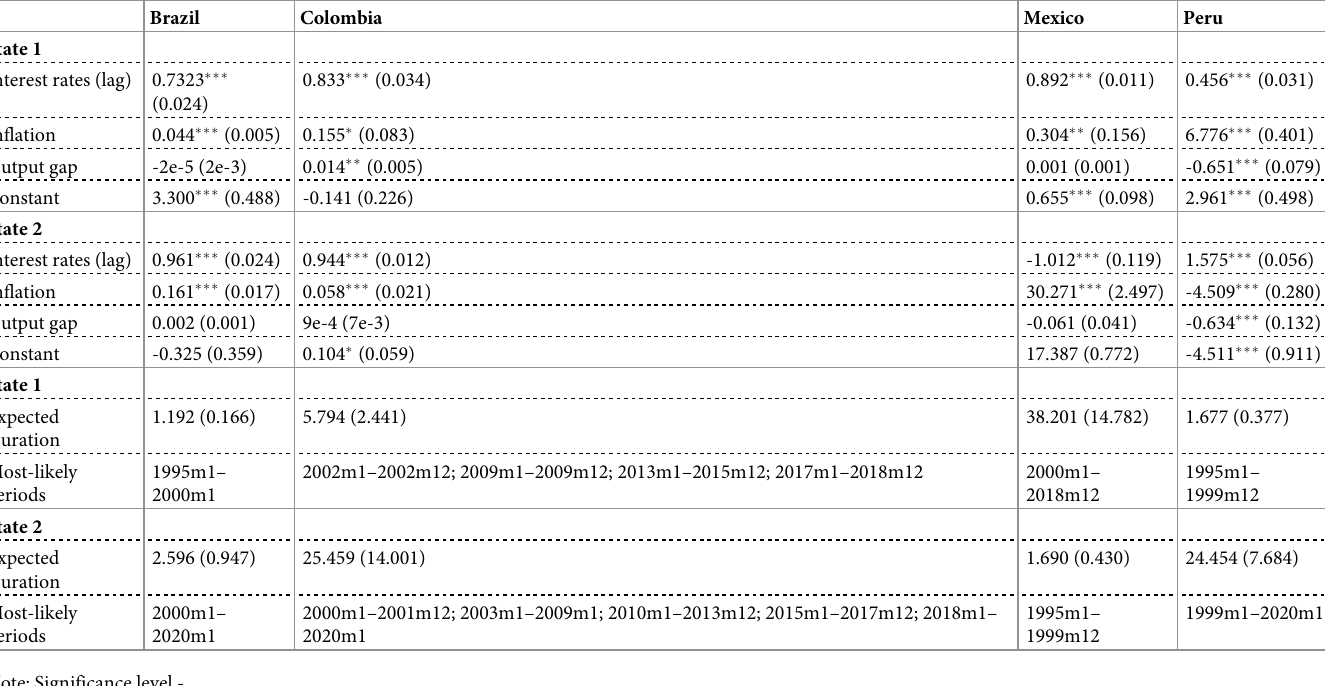
Table 5. MS regressions on Taylor